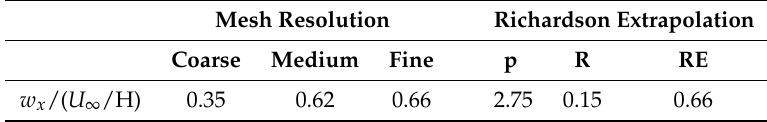
Table 3. Results of the mesh dependency study for the Rectangular VG case 1 .